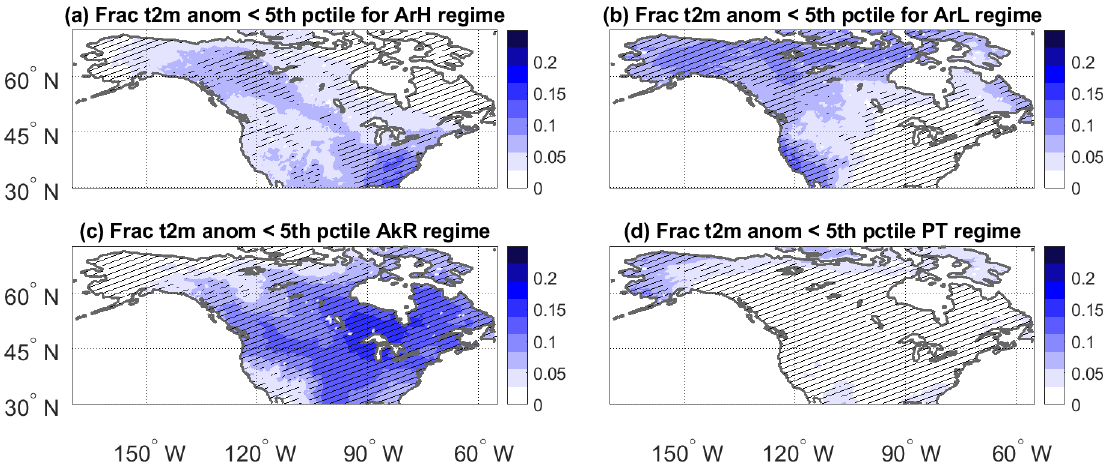
Figure 10. Fraction of t2m anomalies (K) below the local 5th percentile for days in the (a) ArH, (b) ArL, (c) AkR and (d) PT weather regimes. Hatching denotes statistically significant anomalies, assessed as described in Sect.